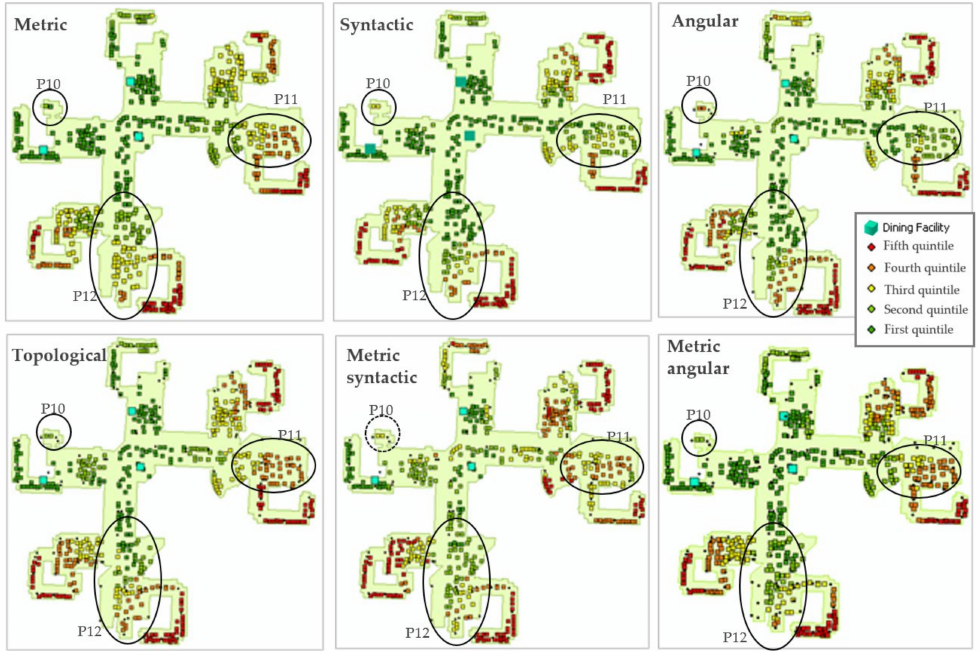
Figure A2. Floor 1 accessibility by different modeling approaches to three dining facilities: classifica- tion in